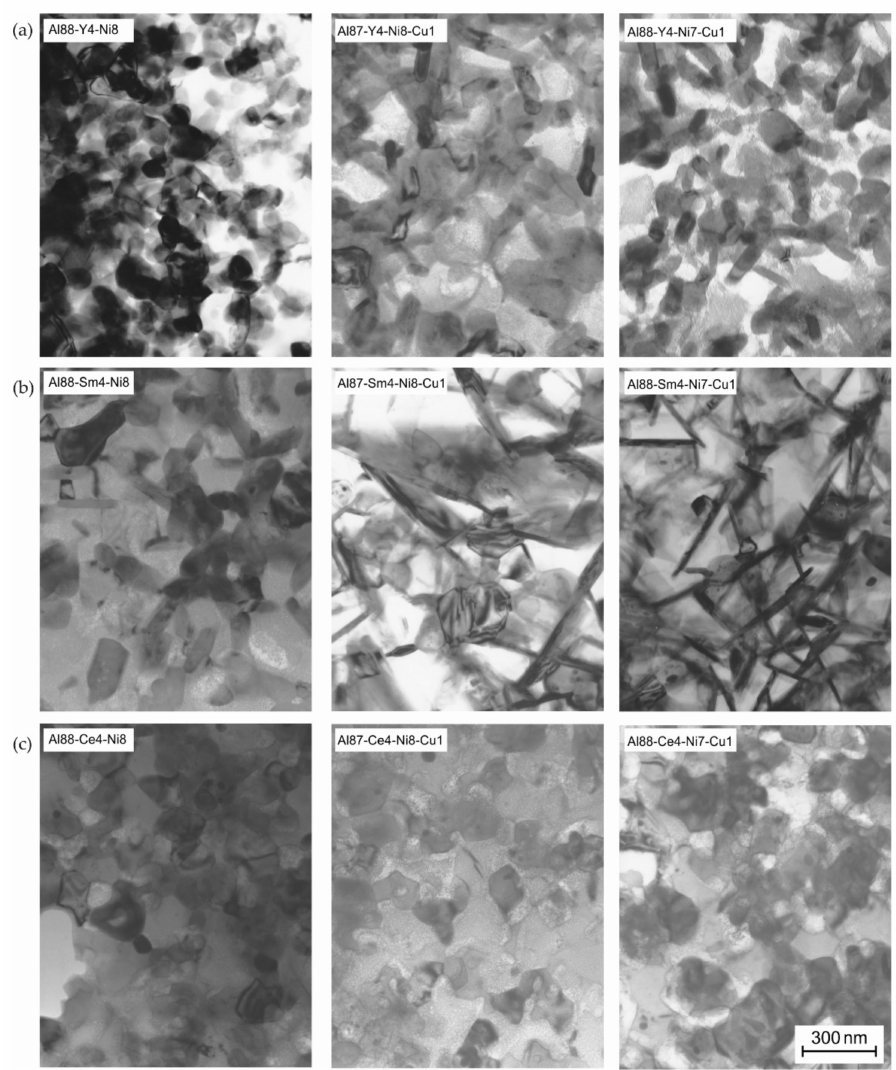
Figure 11. TEM bright field images of heat treated ribbons up to 450 ◦ C of ( a ) Y, ( b ) Sm, and ( c ) Ce-containing